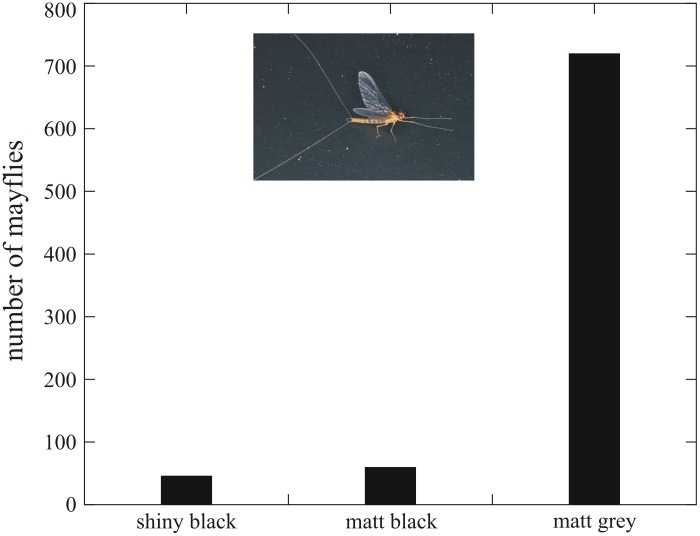
Total numbers of mayflies landed on the shiny black, matt black and matt grey horizontal test surfaces in experiment 1.The inset is a photograph of a mayfly landed on the shiny black test surface. The number of repetition is 6 (see Materials and methods, and Discussion).